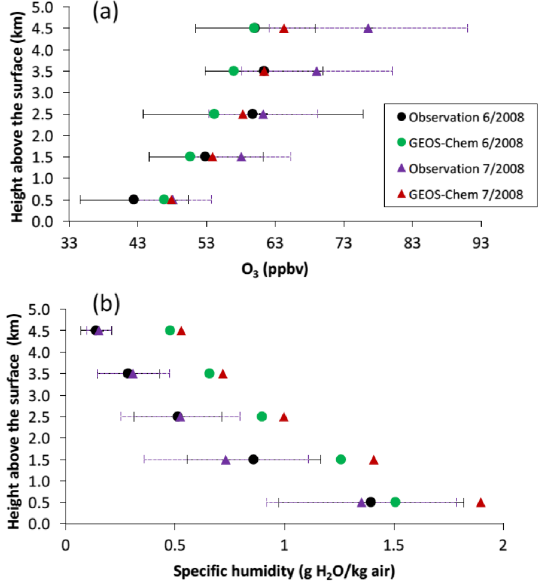
Figure 7. Comparisons of vertical profiles of (a) O 3 and (b) spe- cific humidity between GEOS-Chem simulations and ozonesondes in June and July 2008, respectively, averaged over 1km altitude bins. Black and green solid circles represent observations and sim- ulations in June 2008, while purple and red triangles denote obser- vations and simulations for July 2008. Solid and dashed horizontal error bars represent observational standard deviations for June and July,